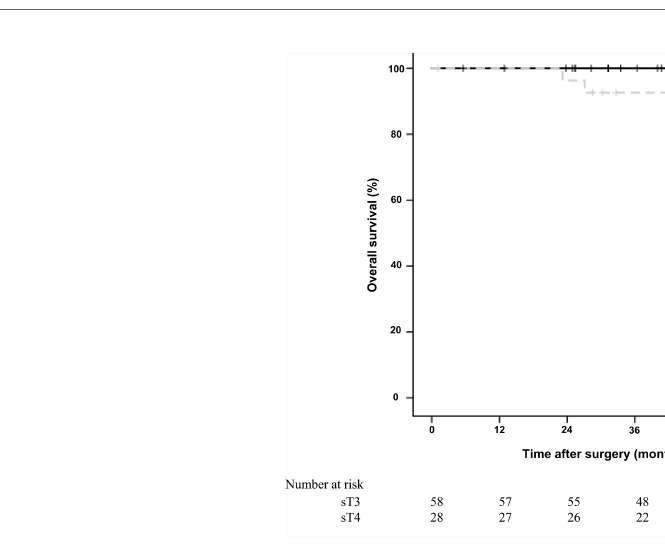
FIGURE 1 | Comparing overall survival for right colon adenocarcinoma between surgical stage T4 (sT4) and surgical stage T3 (sT3) in patients with pT3N0M0 by Kaplan-Meier curve. The 5-year overall survival rate of sT4 group was signi fi cantly lower than that of sT3 groups according to log-rank test (92.6% vs. 97.7%, p